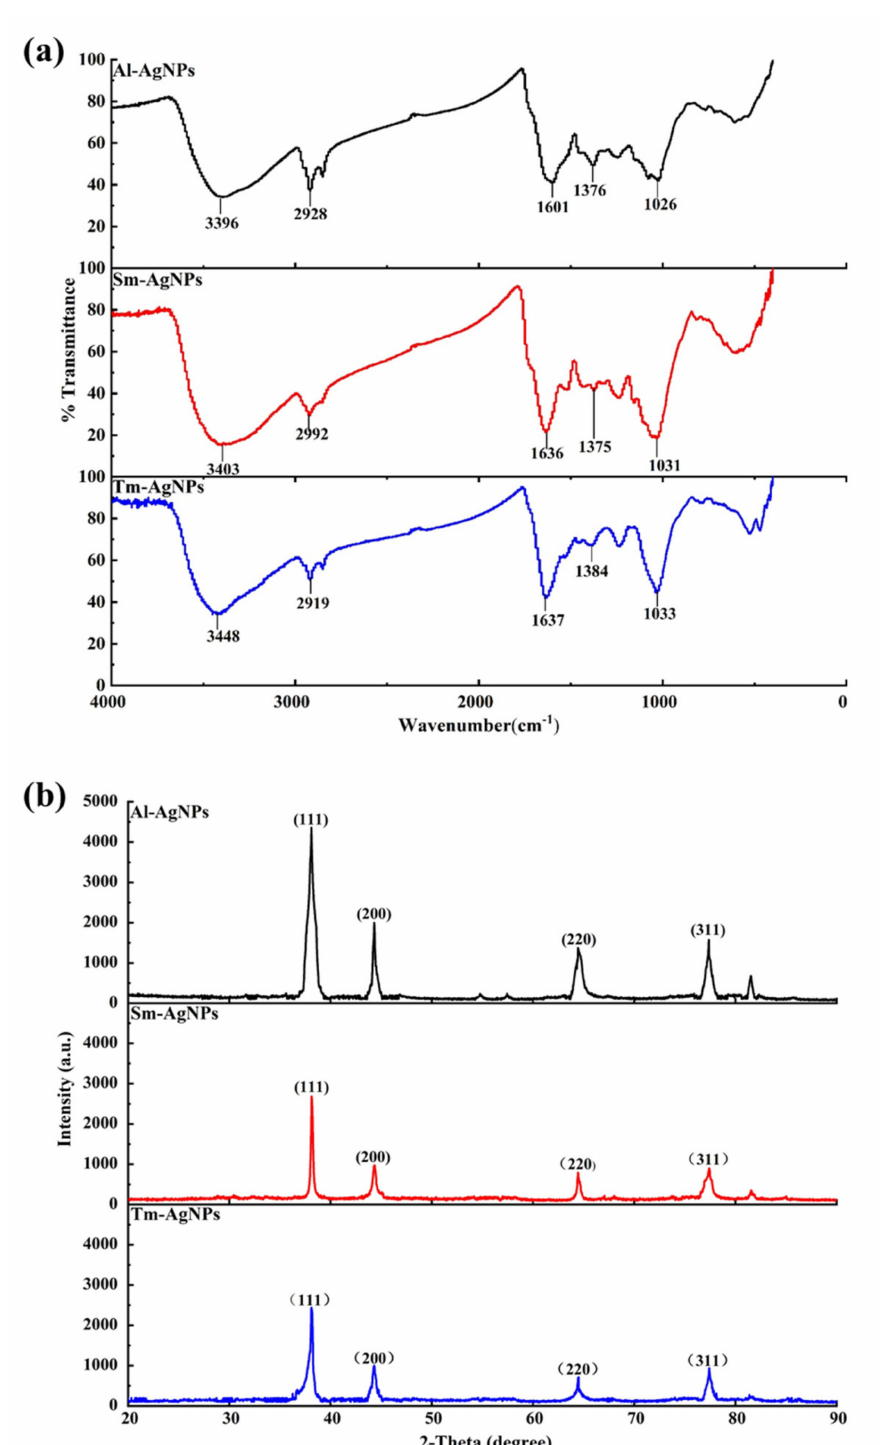
Figure 2. Characterization analysis of Al-AgNPs, Sm-AgNPs and Tm-AgNPs. ( a ) FTIR analysis ( b ) XRD